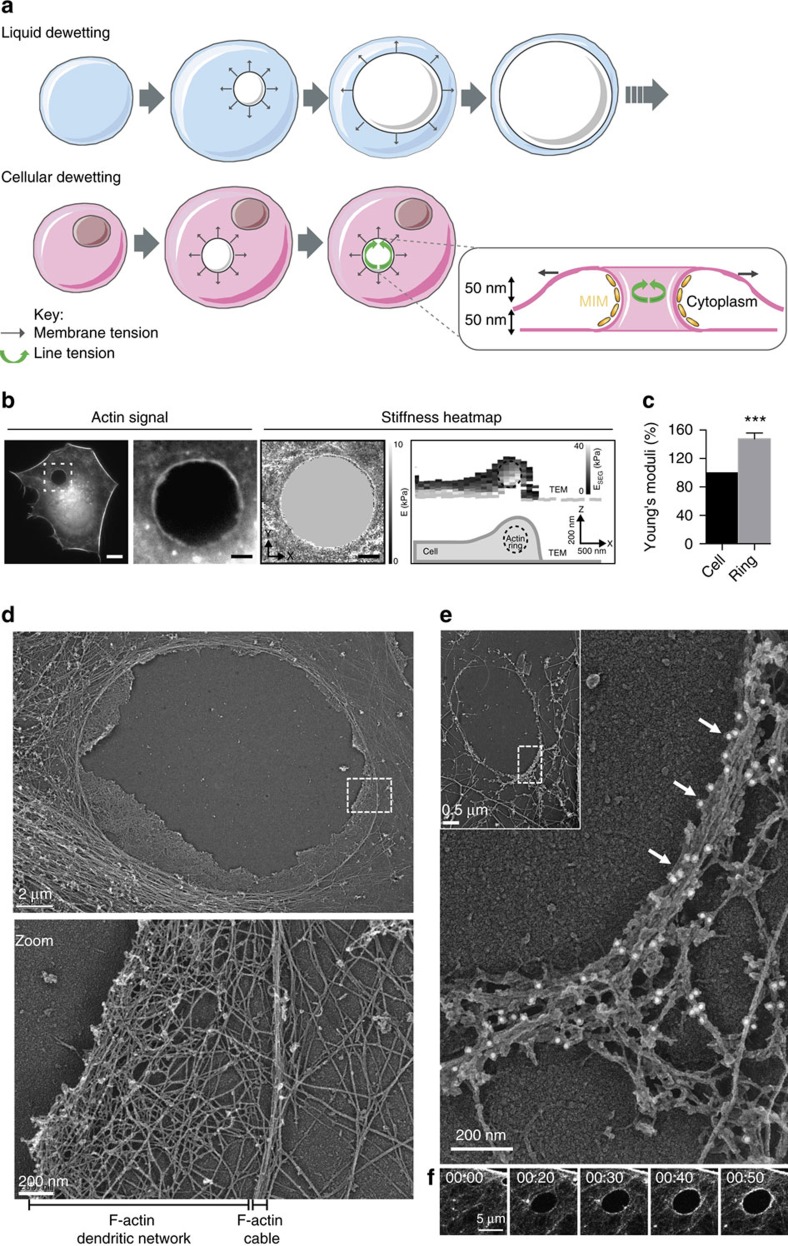
organization of the actomyosin cytoskeleton along TE edges.(a) The dewetting phenomenon describes the rupture of a thin, viscous liquid film on a non-wettable surface, generating a dry patch that widens unlimitedly (top). In the cellular mode of dewetting, cells limit TEM enlargement to a diameter of approximately 10 μm. Holes widen as a function of the tension of the membrane that originates from cell spreading, exerting a tensile force on the tunnel (black arrows). Enlargement of the holes is resisted by a line tension along TEM edges (green arrows). (b) Elasticity of the actin ring encircling TEMs. Left: actin staining in a living cell. Centre: zoomed-in view of the TEM. Right: corresponding living cell elasticity map. Scale bars, white, 10 μm; black, 2 μm. Bottom: Elasticity tomogram showing the height profile together with the actin cable. (c) Bar plot of elasticity. Values correspond to the normalized medians of Young’s moduli±s.d. n=7 TEMs. ***P<0.001, student t-test. (d) Representative example of a platinum replica electron micrograph of TEMs in HUVECs after exoC3 treatment for 24 h. Zoom shows enlarged boxed region. This displays at higher magnification the organization of F-actin into a dendritic meshwork protruding into membrane waves and into an actin bundle at the rear. (e) Electron micrograph of gelsolin-treated cytoskeleton with NMII immunogold labelling at the edge of a TEM. Inset shows an overview of the TEM at lower magnification; boxed region correspond to the main panel. Scale bars are labelled. (f) Representative video images (Supplementary Movie 2) showing the accumulation of LifeAct-GFP signal around a TEM in HUVECs intoxicated for 24 h with exoC3. Scale bars are labelled.